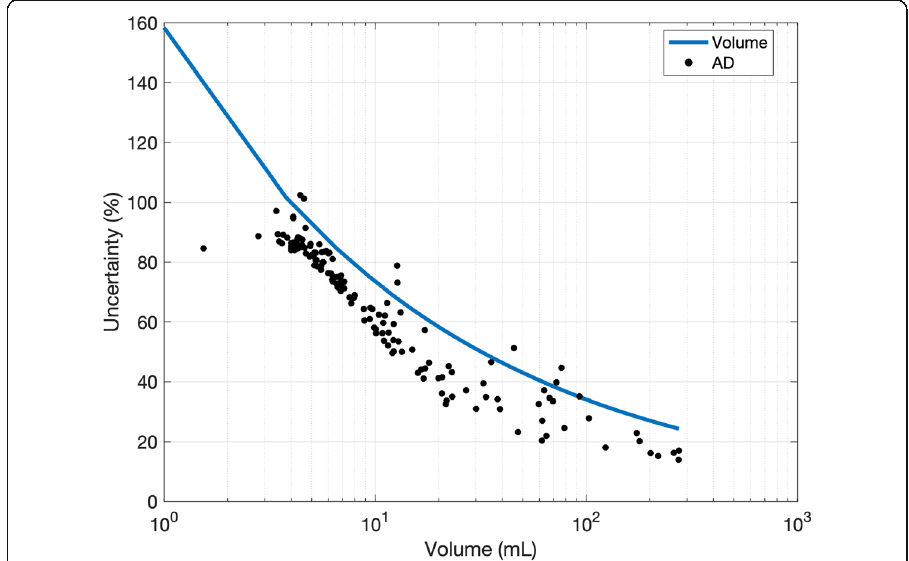
Fig. 8 Absorbed dose uncertainty (black points) and the volume uncertainty (blue line) as a function of the delineated VOI